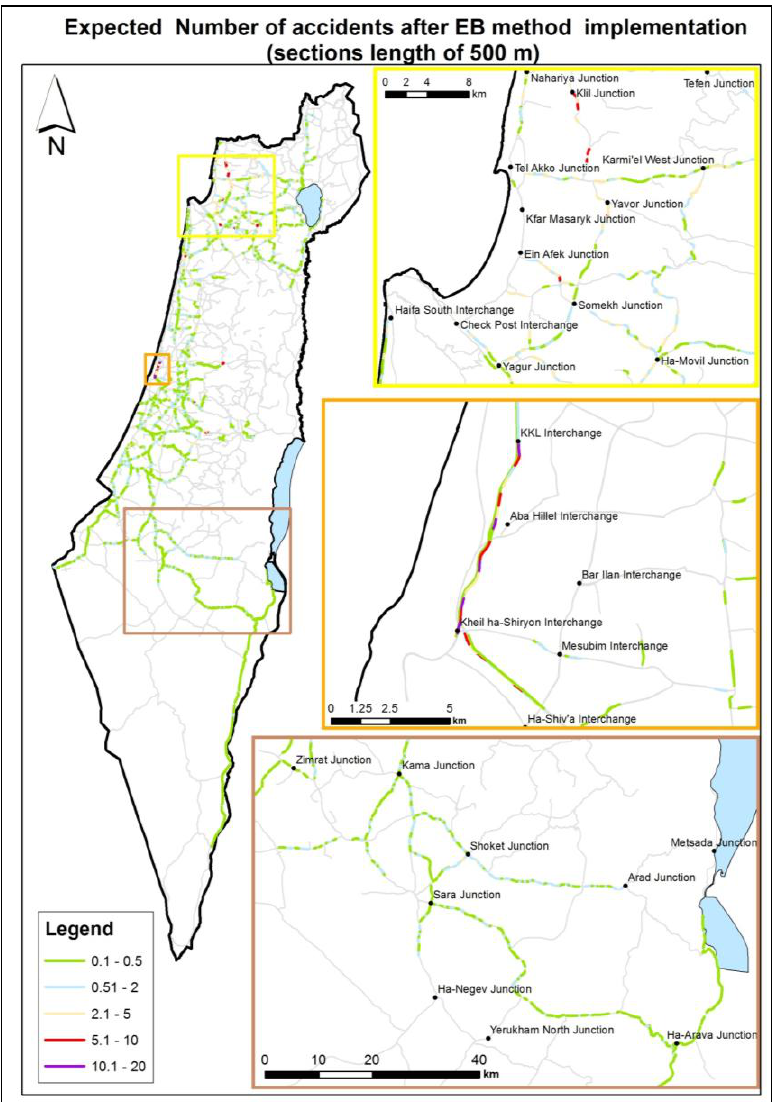
Figure 5. Expected number of accidents (road sections at length of 500